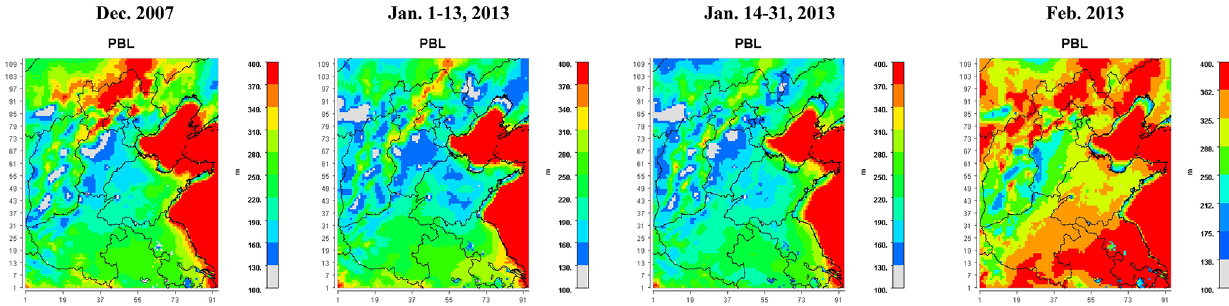
Fig. 8. Spatial distributions of simulated PBL height (m) in Domain 2 in December 2007, and 1–13 and 14–31 January, and February, 2013. Table 5a. The average source contributions (%) to the PM 2 . 5 concentrations in Shijiazhuang, Xingtai, and Handan by source regions: Regions